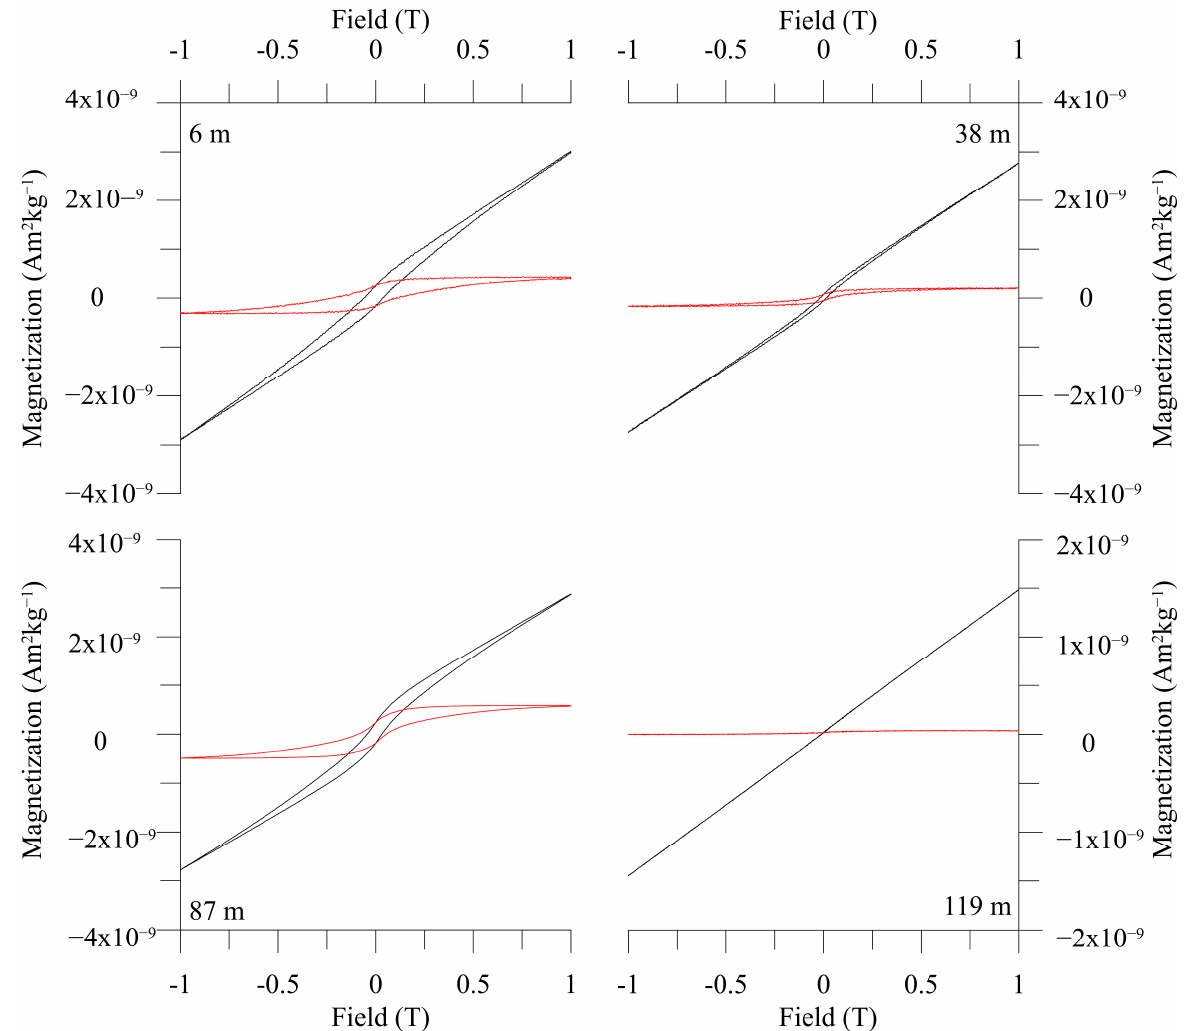
Figure 5. Hysteresis loops of representative samples from the TTH-D section. The black and red loops of each sample are the original and paramagnetic corrected loops, respectively.